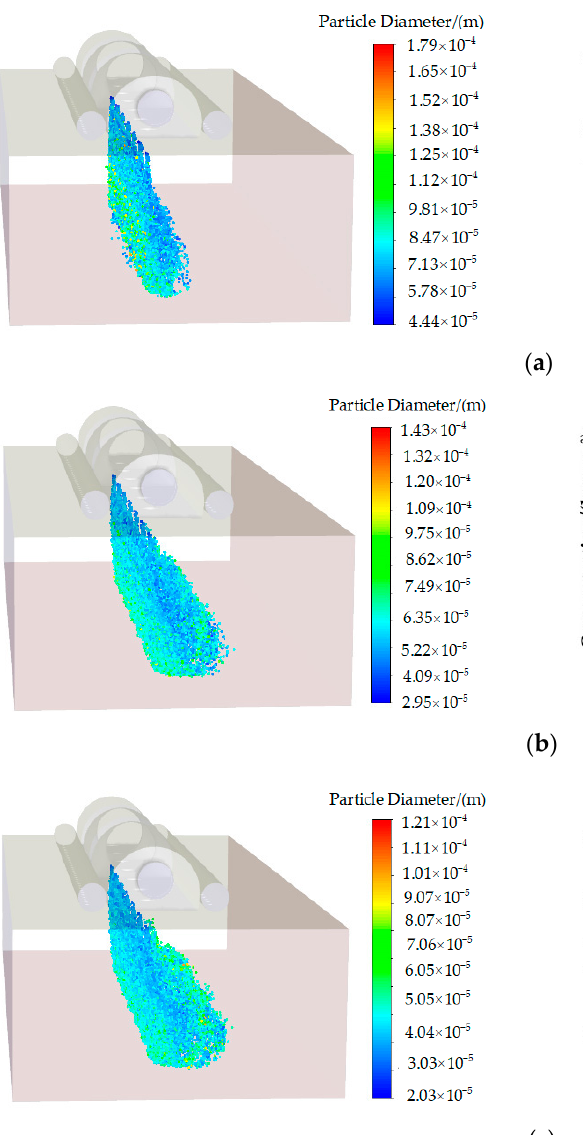
Table 3. Experimental design and range analysis. Exp. No.